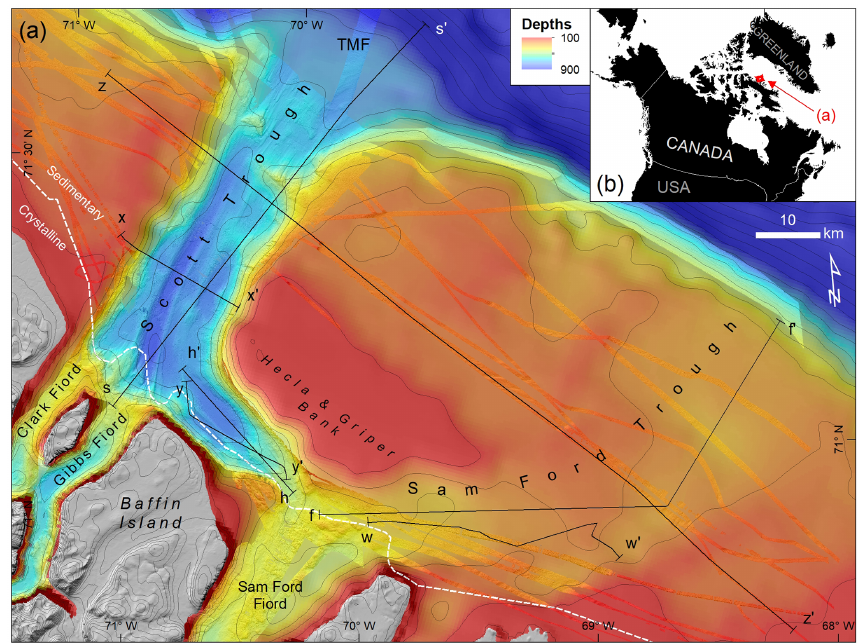
Figure 1. (a) Map showing the high-resolution bathymetric data collected by ArcticNet program (2003–2016) draped on the International Bathymetric Chart of the Arctic Ocean data (IBCAO; Jakobsson et al., 2012) map of the northeastern Baffin Island shelf. The black dashed line shows the approximate limit between sedimentary and crystalline bedrock. HGT: Hecla & Griper Trough. Light gray lines: 100m contours. Dashed black lines: ice-stream lateral moraines on the sides of Sam Ford Trough. (b) Location of the study